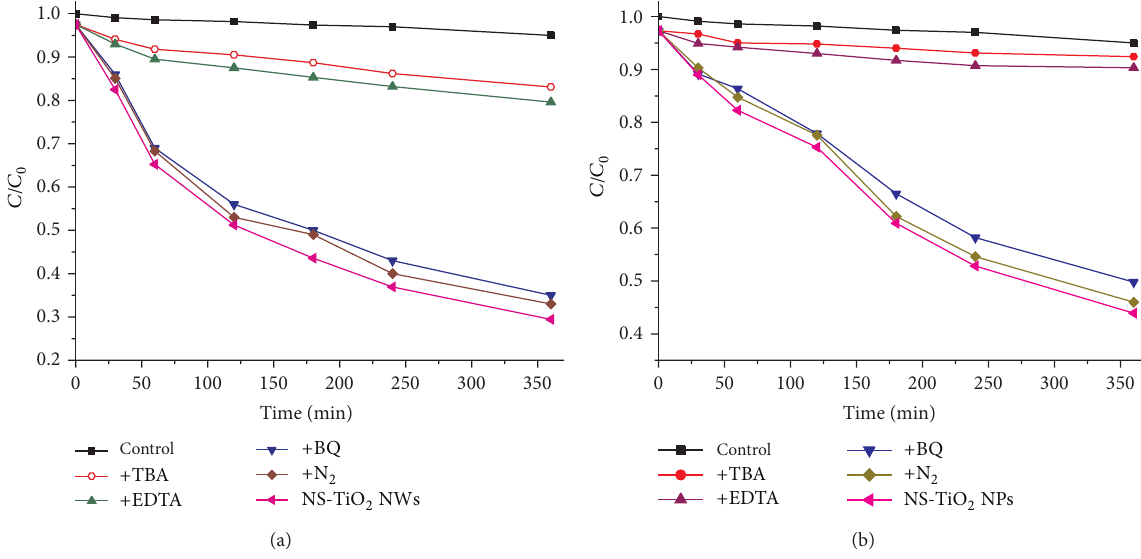
Figure 9: Atrazine degradation of (a) NS-TiO 2 NWs and (b) NS-TiO 2 NPs under different conditions under visible light irradiation.